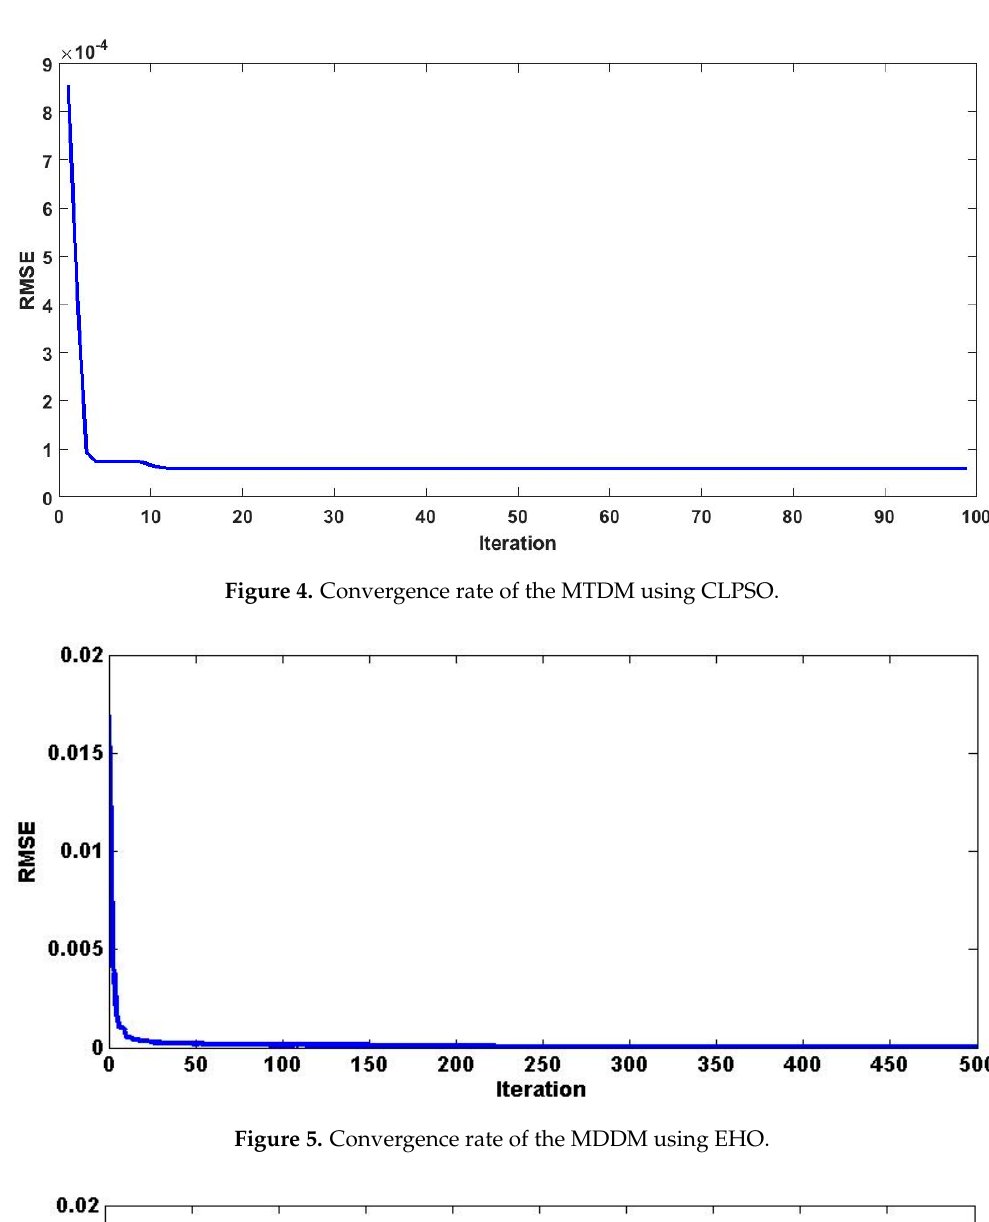
Figure 3. Convergence rate for the MDDM using CLPSO.